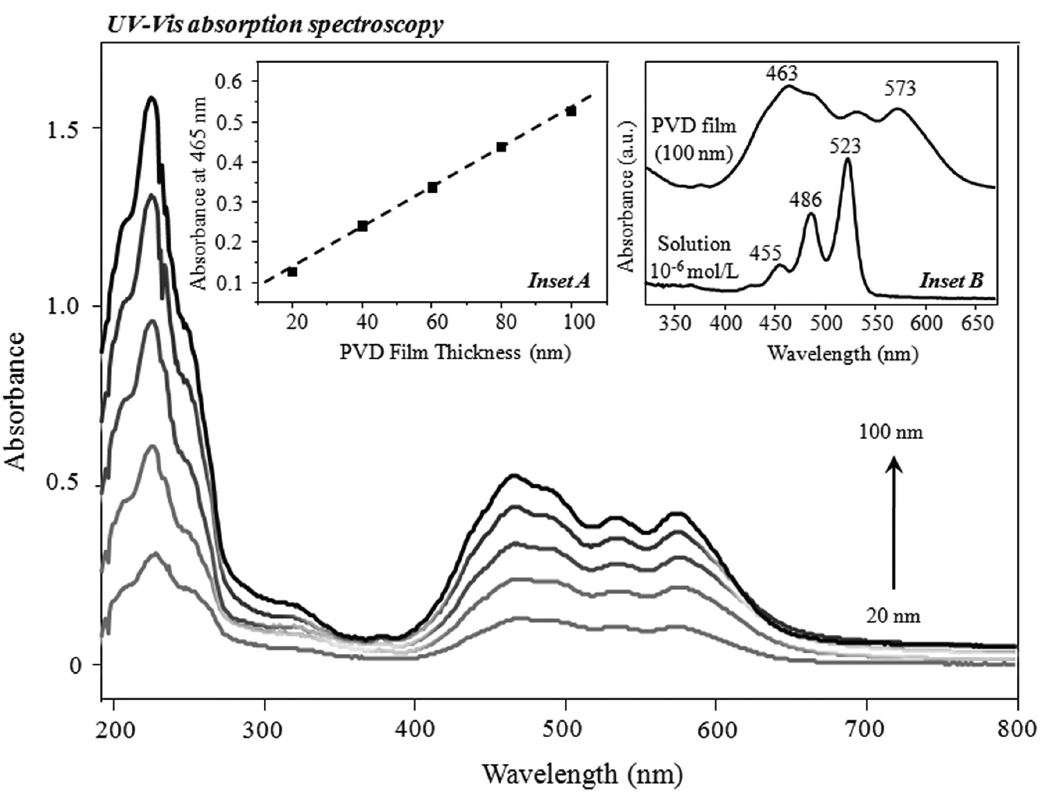
Figure 2. UV-Vis absorption spectra for BuPTCD PVD films with 20, 40, 60, 80, and 100 nm. The insets show (A) the absorbance at 465 nm for each evaporation step and (B) the absorption spectra for both BuPTCD solution (10 -6 mol/L) and PVD film (100